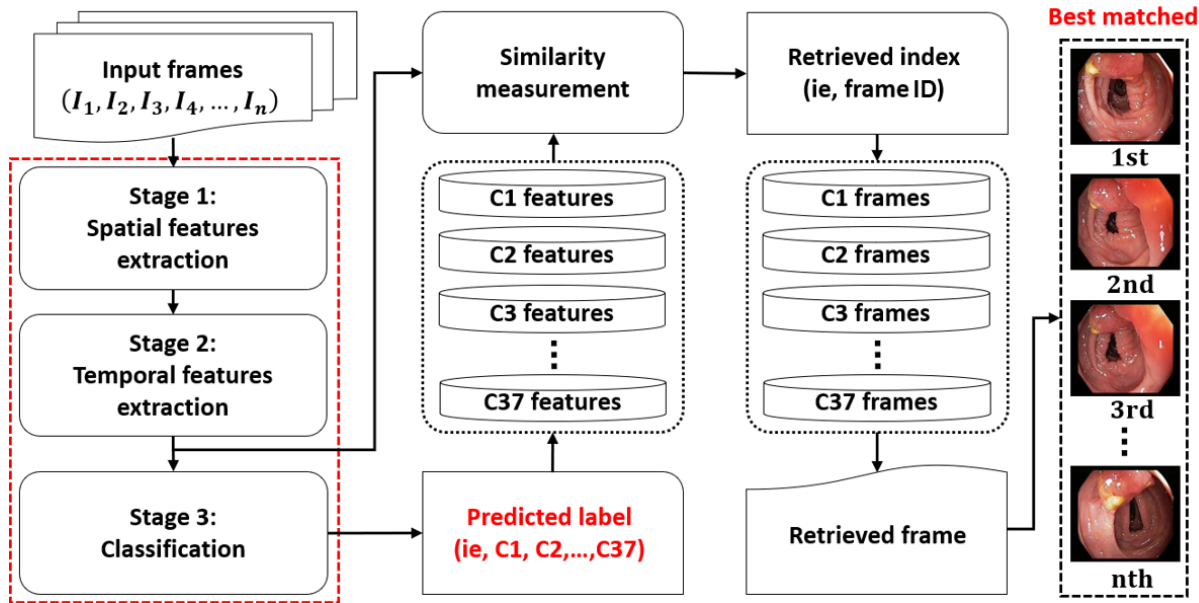
Figure 1. Comprehensive flow diagram of the proposed classification and retrieval framework. The red dotted box highlights our major contributions in this proposed retrieval